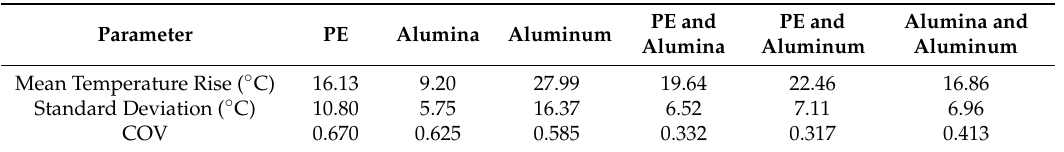
Table 2. Non-uniformity, as calculated by COV with 2919 mesh dots, in potato temperature distribution after 12 s heating with a turntable composed of multiple materials or a single material.